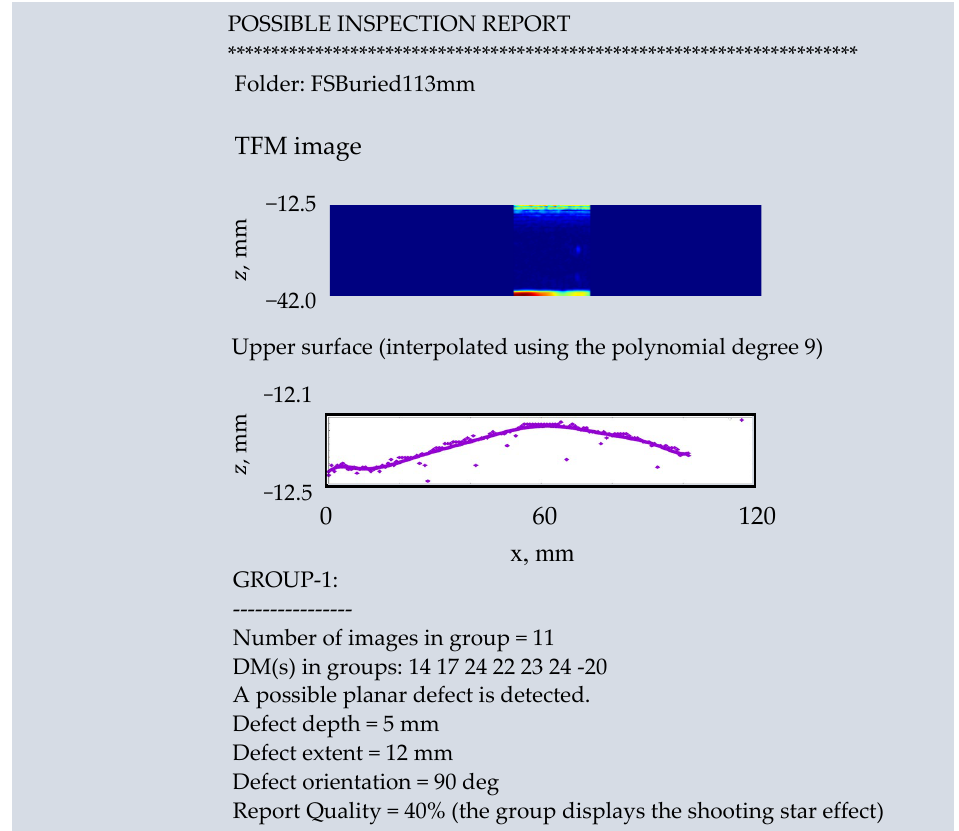
Figure 7. DPS data set: the buried notch located 113 mm from the left edge, imaged from the flat side. MTFM images have been obtained with intensity threshold = 185 and Dm = ( a ) 24; ( b ) 21. Key: E—notch extent, D—notch depth and O—notch orientation. The portion of the image to the left of the region of interest is cut off.